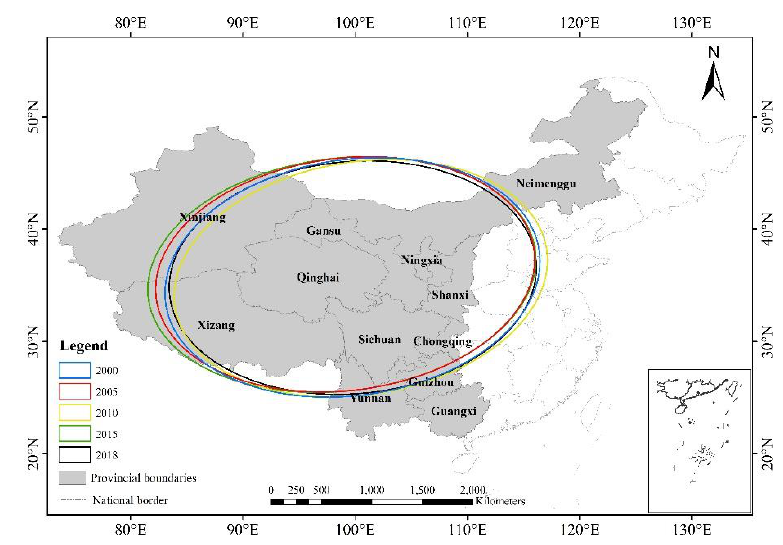
Figure 6. Spatial distribution pattern and center of gravity transfer of annual average vegetation cover in West China